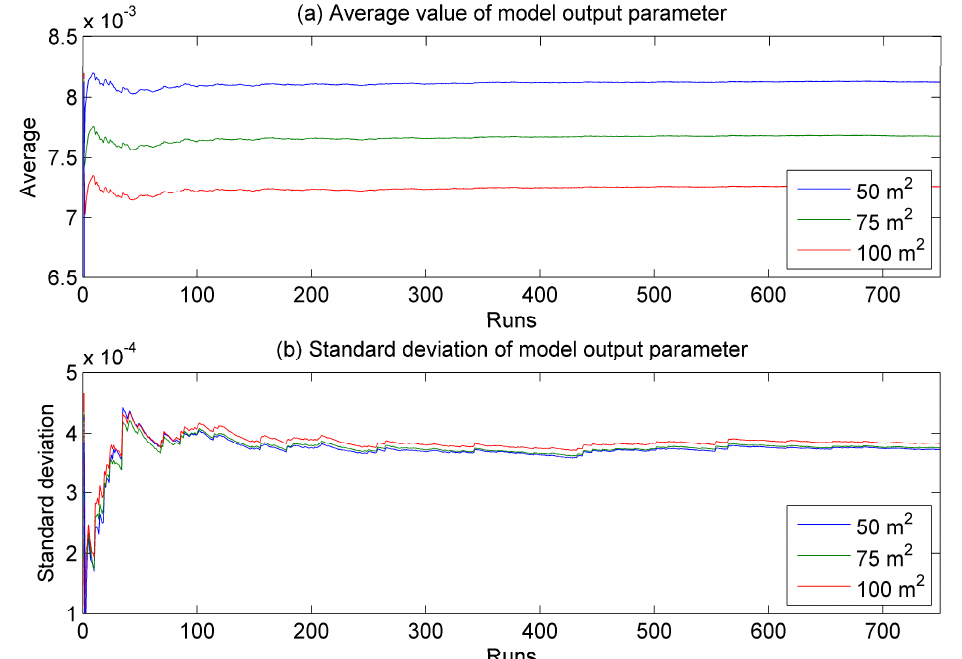
Figure 5. Average (top) and standard deviation (bottom) of relevant model output parameter (i.e., average infection probability per year). ( a ) Average value of model output parameter; ( b ) Standard deviation of model output parameter.